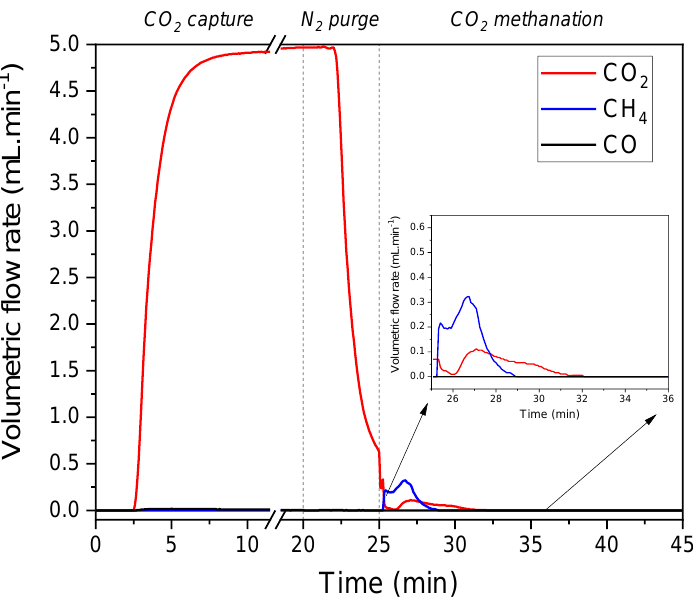
Figure 5. Volumetric flow rates (mL min − 1 ) of CO 2 , CO, and CH 4 during CO 2 capture and methana- tion experiment with NiRuK/CeAl ( T = 350 °C, P = 1 atm).